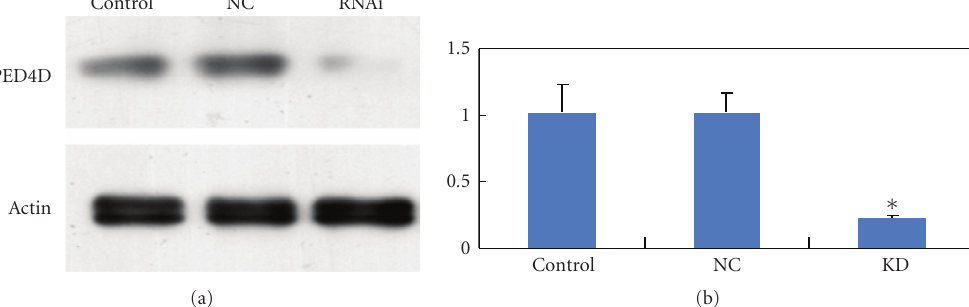
Figure 1: Knockdown of endogenous PDE4D expression by lentiviral vector-mediated shRNA in VSMCs. VSMCs were infected with the same amount (PDE4D-shRNA: 12.5 μ L, nonsense shRNA: 6.25 μ L) of lentivirus particles carrying either shRNA (titer 4 × 10 8 TU/mL) against PDE4D or nonsense shRNA (titer 8 × 10 8 TU/mL). PDE4D protein expression was determined at 48 hours postinfection. Values represent means ± SEM. E: inhibition of PDE4D expression in PDE4D shRNA-tranfected cells was calculated relative to the PDE4D expression in cells tranfected with the control nonsenseshRNA. Sh-GFP: lentivirus particles carrying nonsenseshRNA, Sh-PDE4D: lentivirus particles carrying shRNA against